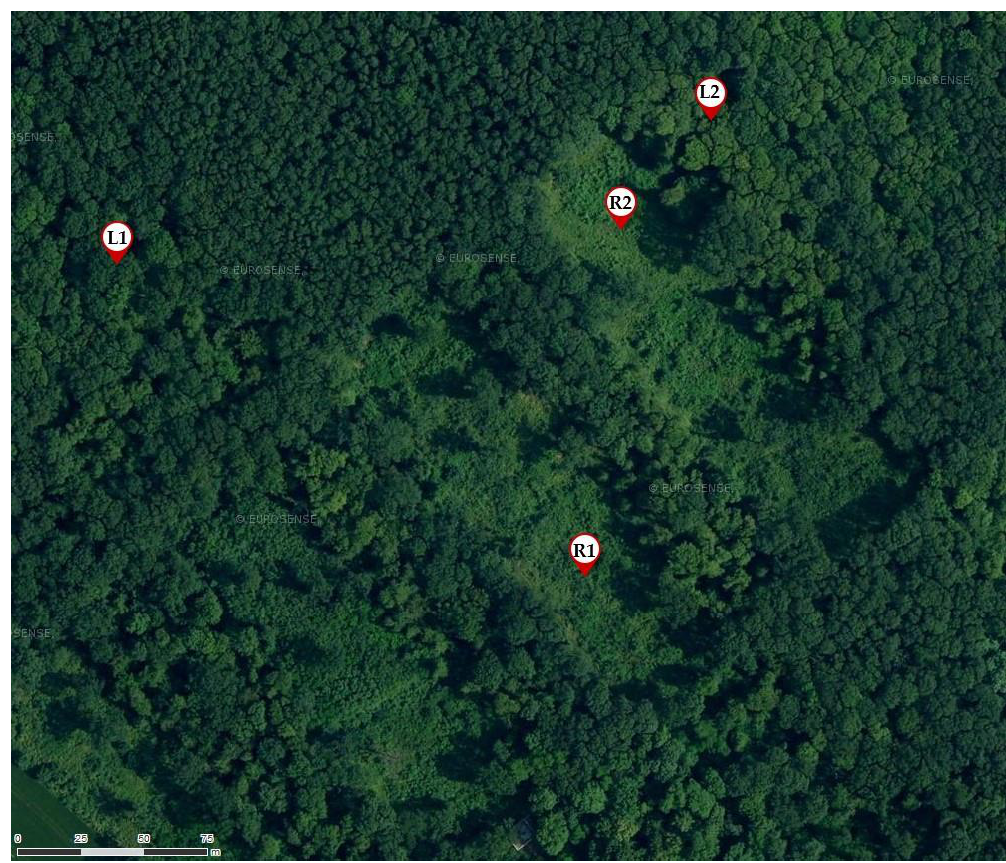
Figure A1. The forest research area in Báb with the localizations of the research plots. (R1, R2, L1, L2). The picture is a screenshot of an aerial map from the mapy.cz web application. The tool for adding the marks on the map was that used [48].